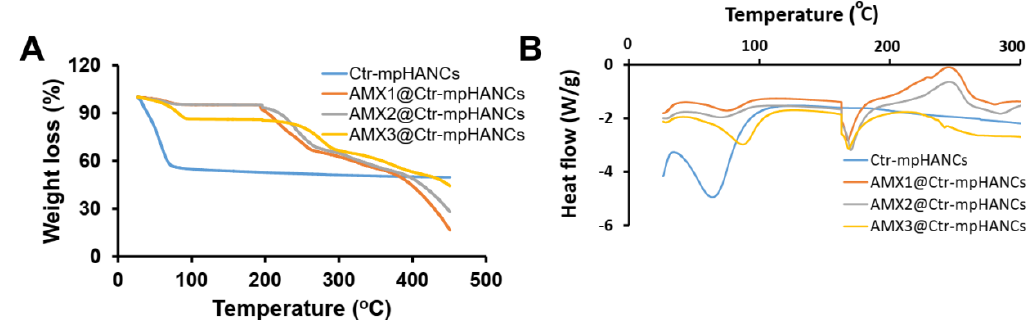
Figure 4. ( A ) TGA and ( B ) DSC of sole and AMX-loaded Ctr–mpHANCs